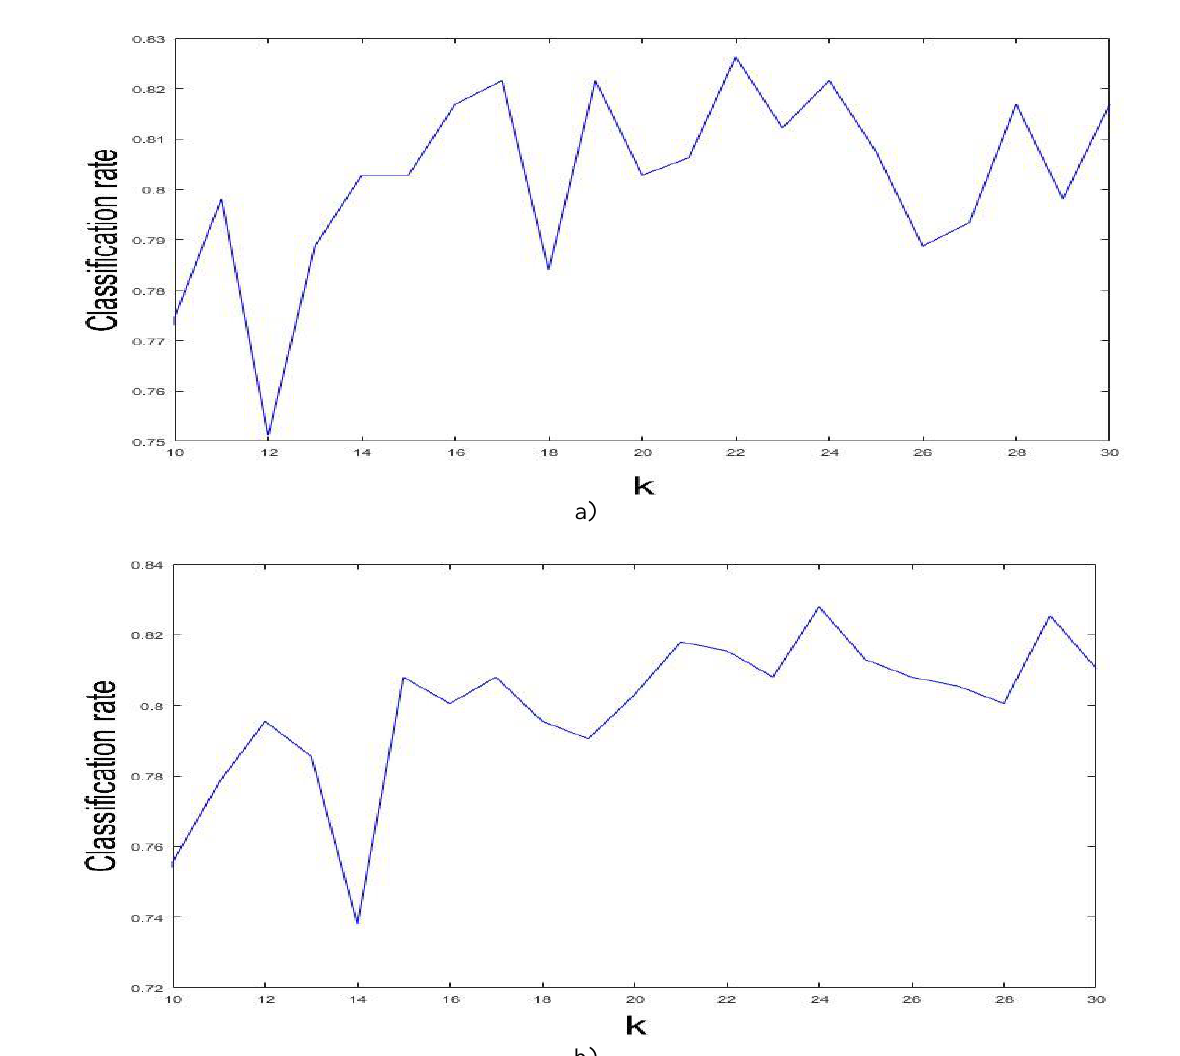
Figure 4. Classification rates achieved by different ranks in (a) JAFFE dataset and (b) MUG